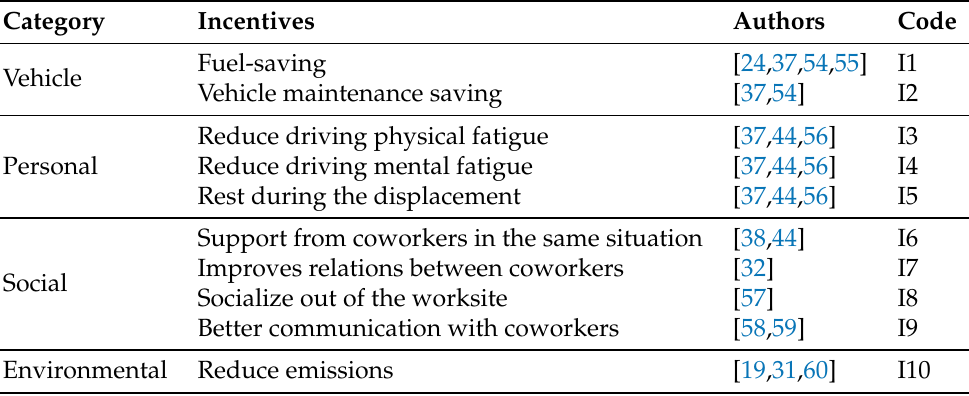
Table 3. Incentives to adopting carpooling for commuting.